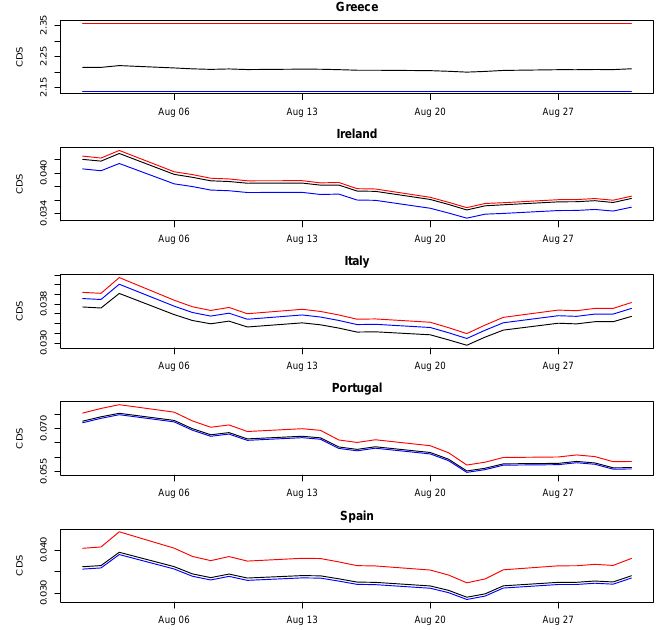
Figure 8. August 2012, predictive performance for core countries. For each considered core country, the graphs report the observed CDS spreads at time t (black line), the CDS spreads predicted at time t − 1 using the proposed model (red line) and the CDS spreads predicted at time t − 1 using only the autoregressive component (blue